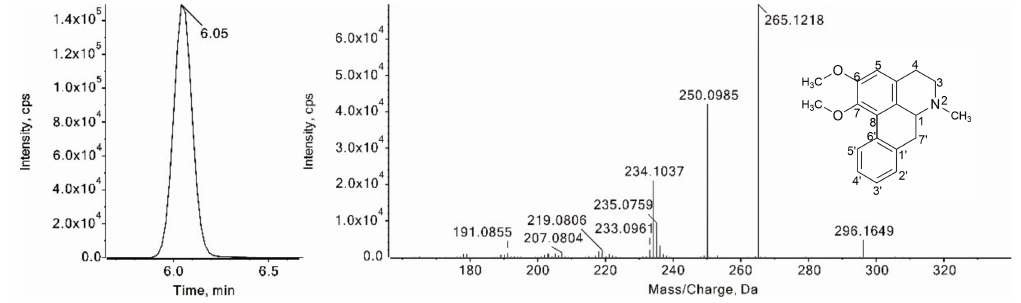
Figure 8. XIC and the MS/MS spectrum of